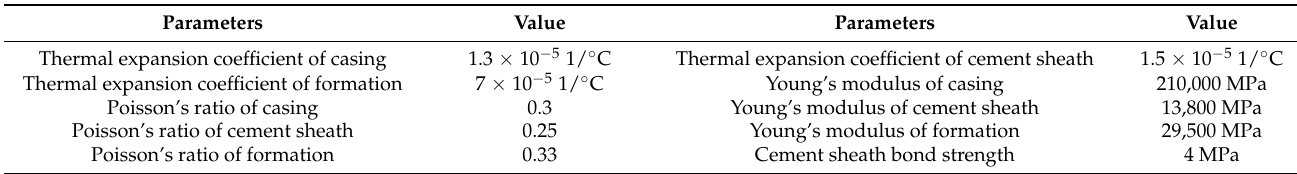
Table 3. Physical parameters of the casing, cement sheath, and